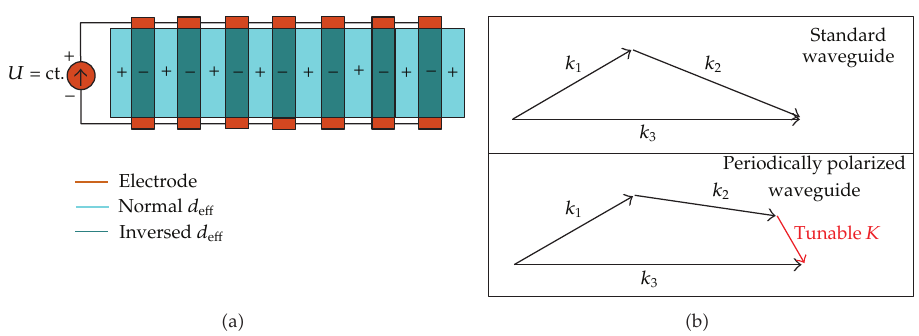
Figure 2: Entangled photon pair generation devices: (cid:8) a (cid:9) periodically poled waveguide structure; (cid:8) b (cid:9) phase matching and quasiphase matching for waveguides.